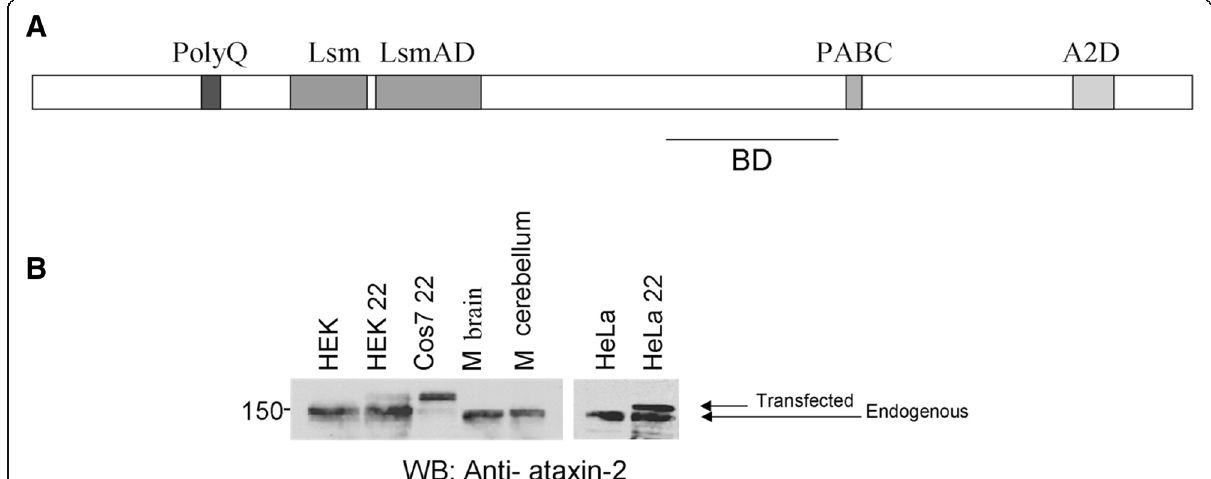
Fig. 1 a Scheme of known ataxin-2 protein domains, with the site that is recognized by the monoclonal BD antibody. b Western-blot for ataxin-2 in different cell lines and mouse brain. Non-transfected and transfected (labelled 22 to indicate recombinant human wildtype ataxin-2 with a polyglutamine tract of 22 units) HeLa and HEK293, transfected COS-7 cell lysates as well as mouse brain and cerebellum lysates were loaded on a 8% SDS-PAGE gel. Detection of ataxin-2 in the transfected cells showed 2 bands, corresponding to the endogenous (lower band) and the transfected ataxin-2 protein (upper band), in comparison to the presence of a unique endogenous ataxin-2 band in the non-transfected cell lysates, in mouse brain and cerebellum extracts